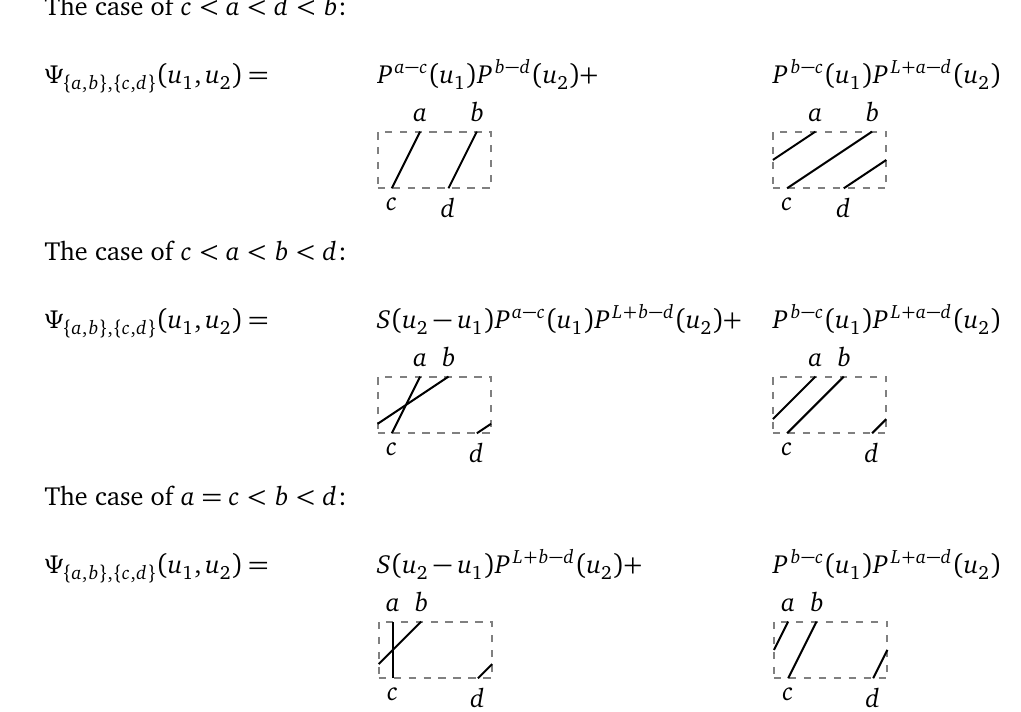
( u ) in three dif- , u a , b } , { c , d } 1 2 − u ) 2 1